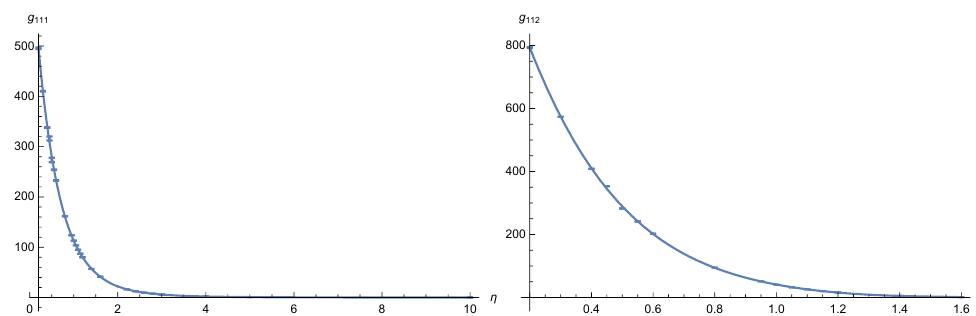
Figure 8. The 3-point couplings g 111 and g 112 as functions of η , determined numerically from the analytically continued S ( z ) through method II of section 2.2 and then interpolated, with (very small) error bars produced using (2.17).